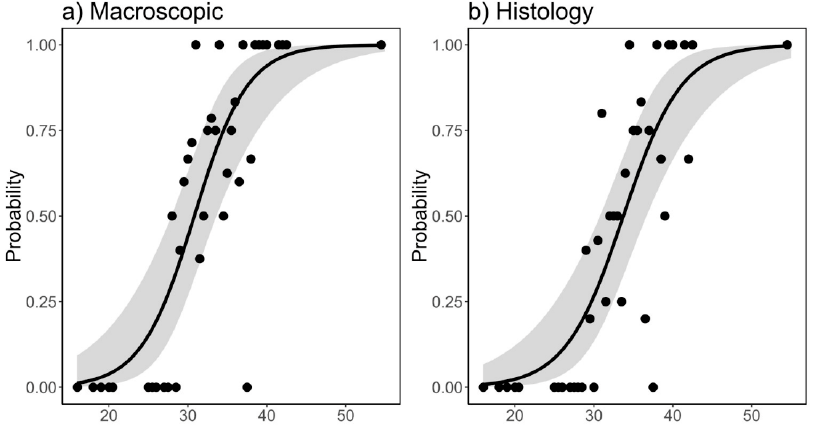
Figure 7. Estimated L 50 and observed the proportion of mature individuals by 1 cm length classes. ( a ) Macroscopic value; ( b ) histological value. The shaded area indicates a 95% confidence interval. The estimated parameters of the logistic regression were statistically significant ( p < 0.05) and summarized in Table 2. Table 2. Summary of the L50 estimates based on histological and macroscopic data. Model Estimates HISTOLOGY Estimate